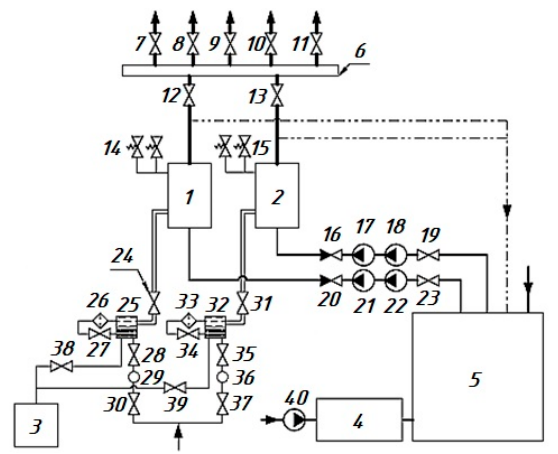
Figure 2. Schematic of the MTPB: (1, 2) steam boiler; (3) reserve fuel tank; (4) chemical water treatment unit; (5) nutritional container; (6) distribution manifold; (7–9) valve (steam to the consumer); (10) valve (steam for own needs); (11) valve (steam for heating the tank); (12, 13) valve; (14, 15) relief safety valve; (16, 20) check valve; (17, 18, 21, 22) feed pump; (19, 23, 24, 27, 28, 30, 31, 34, 35, 37–39) valve; (25, 32) separator; (26, 33) fine filter; (29, 36) coarse filter; (40) pump.